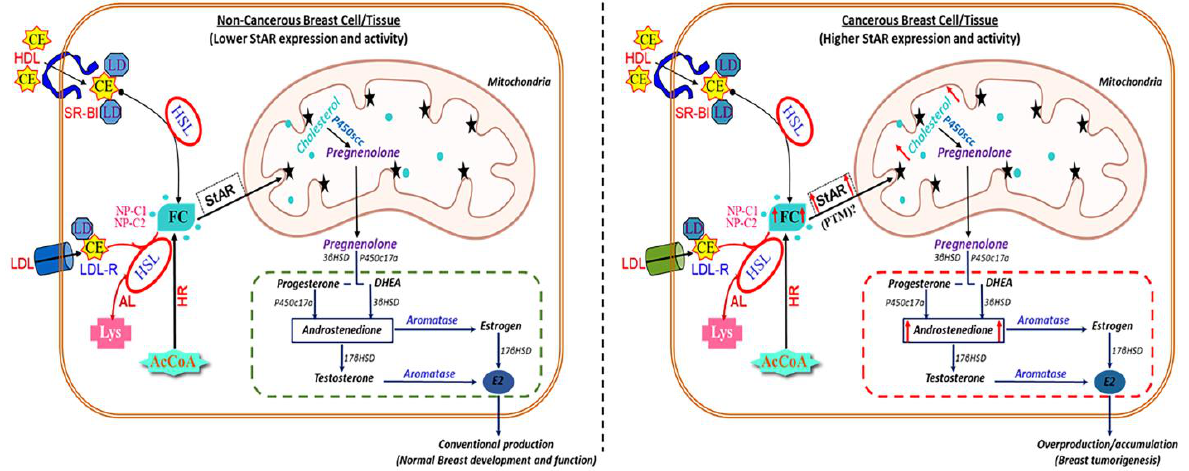
Figure 8. A schematic model illustrating the potential mechanism of StAR-mediated cholesterol utilization in non-cancerous and cancerous breast cells/tissues. Cholesterol used for steroidogen- esis derives from a variety of sources. Circulating lipoproteins (high-density lipoprotein, HDL or low-density lipoprotein, LDL) bind to scavenger receptor, class B type 1 (SR-B1) and LDL-receptor, re- spectively, to release cholesterol esters (CEs) into cells. Hormone-sensitive lipase (HSL) generates free cholesterol (FC) from CEs. FC also arises from de novo synthesis from acetyl-CoA. The conver- sion of CEs into FC serves as an important step in controlling cholesterol availability for steroido- genesis. The StAR protein regulates steroid biosynthesis by controlling the intra-mitochondrial transport of cholesterol. At the mitochondria, the cytochrome P450scc enzyme converts cholesterol to pregnenolone, which exits the mitochondria and is then converted to various steroid hormones, including androgens and estrogen/E2, by various enzymes. Under physiologic conditions, StAR ex- pression is moderate in breast cell/tissue, supporting appropriate synthesis of E2 for normal breast development and function ( left panel ). However, in cancerous breast cell/tissue, StAR expression is aberrantly high that presumably facilitates abnormal cholesterol delivery to the inner mitochondrial membrane and, as a consequence, abundant availability of androgen precursors for E2 accumula- tion in promoting tumorigenesis ( right panel ). Green and red dotted rectangles illustrate conven- tional and overproduction of E2 associated with normal breast development/function and breast tumorigenesis, respectively. LDL-R, LDL receptor; AL, acid lipase; Lys, lysosome; HR, HMG-CoA reductase; NP-C1/C2, Niemann-Pick type C1/C2; , increase expression/activity.